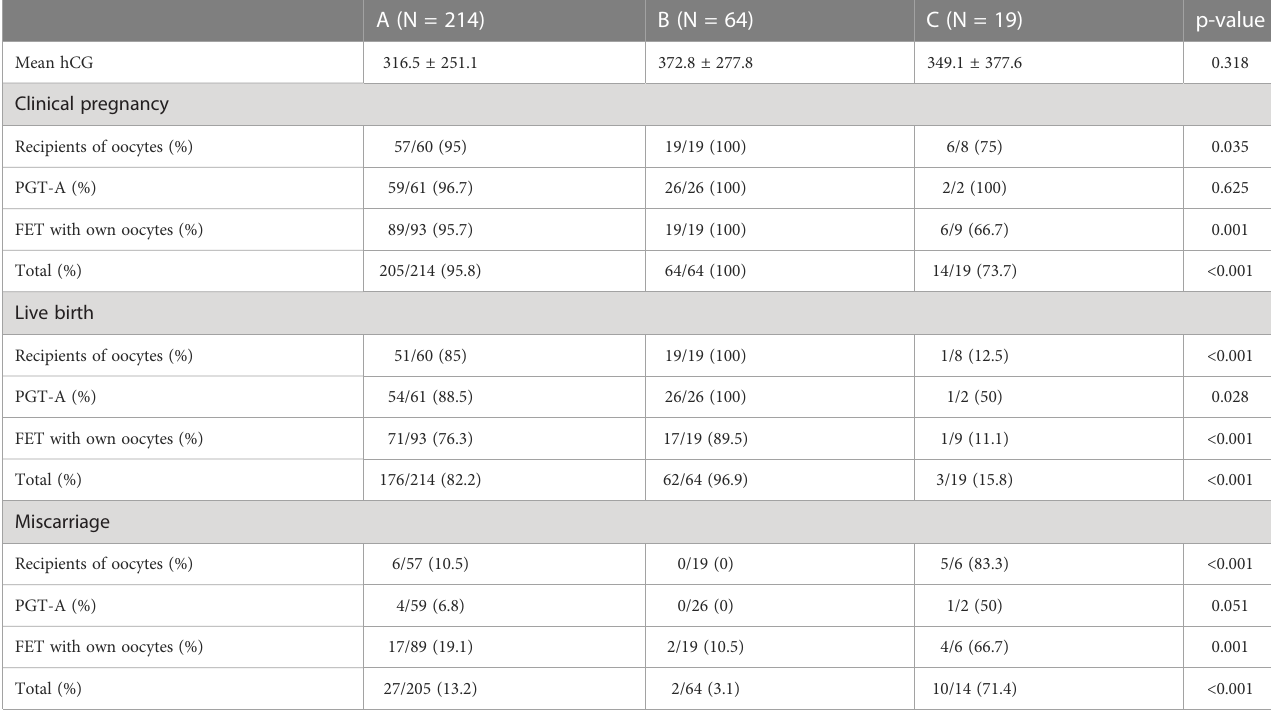
TABLE 5 Clinical outcomes per group of progesterone and supplementation or not for all the pregnancies with fi rst hCG value ≥ 100 IU. A (N = 214) B (N = 64) C (N = 19) p-value Mean hCG 316.5 ±